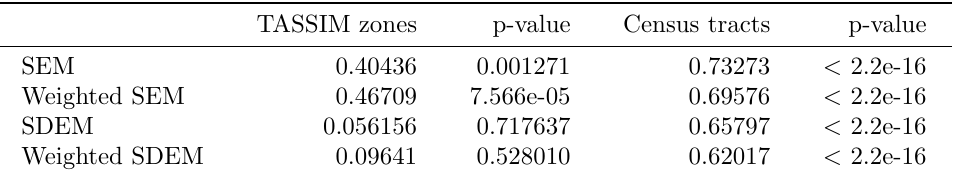
Table A.10: Spatial coefficient ρ values and Wald test p-values for spatial error and Err spatial Durbin error models for weighted and unweighted models and the 489 census tract data set and the 96 TASSIM zone data set.